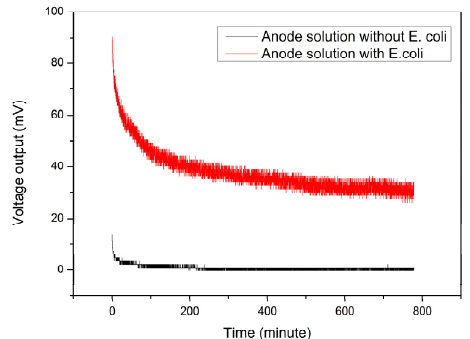
Figure 8. Effect of E. coli on the voltage output of the MFC system.